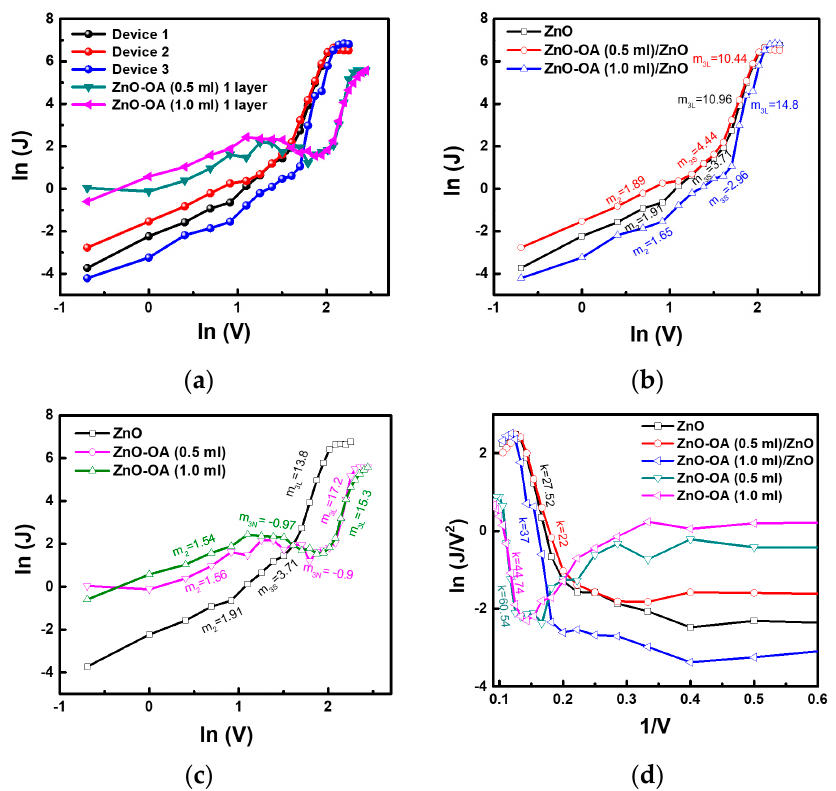
Figure 17. ( a ) current density (J) − voltage (V) curves for QLEDs − S1, − S2, − S3, − D1 and − D2. ln(J) − ln(V) curves of ( b ) QLEDs − S1, − D1, and − D2, and ( c ) QLEDs − S1, − S2, − S3. ( d ) ln(J/V 2 )(1/V) for QLEDs − S1, − S2, − S3, − D1, and − D2.